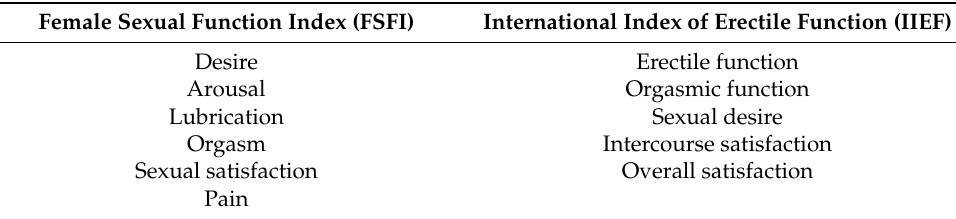
Table 2. Areas assessed by the diagnostic tools in women (Female Sexual Function Index) and men (International Index of Erectile Function)